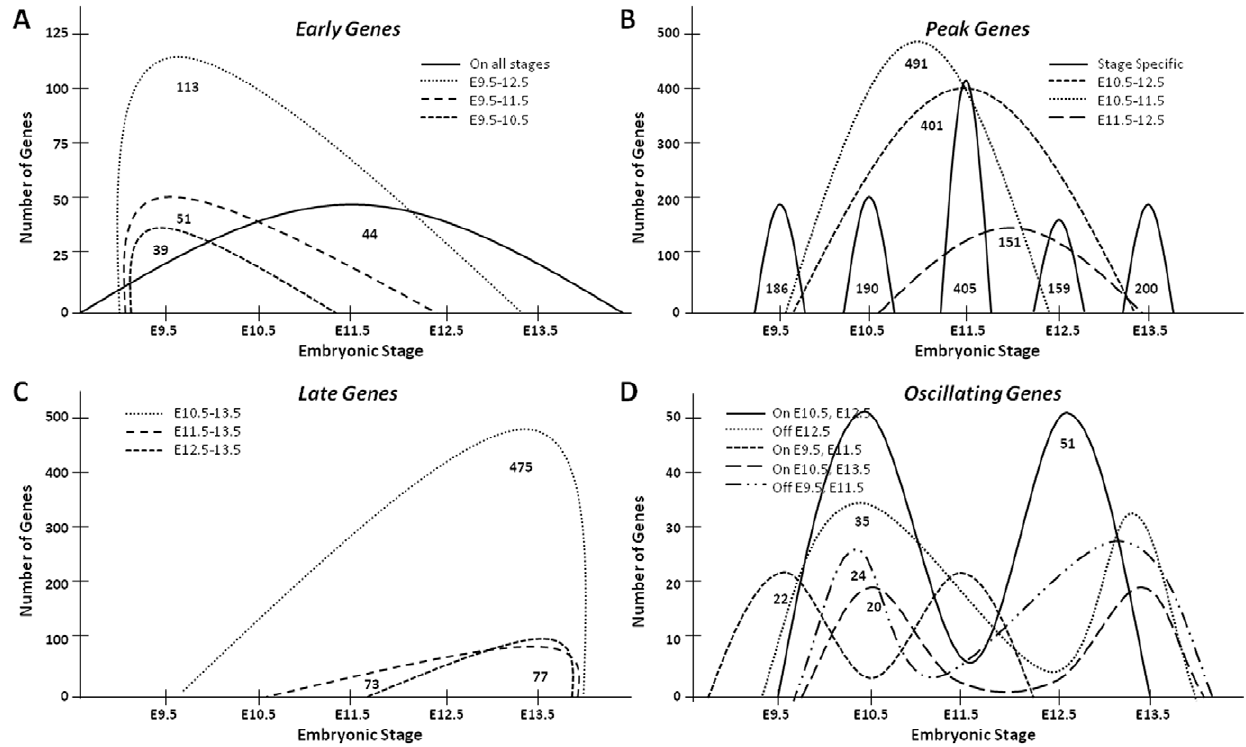
Figure 4. Temporal Expression Pattern Analysis in the Developing Forelimb. Clusters of co-transcribed genes were grouped into early genes (A), peak genes (B), late genes (C) and oscillating genes (D) based on their profiles. The number of genes corresponding to each curve are indicated below the trace.